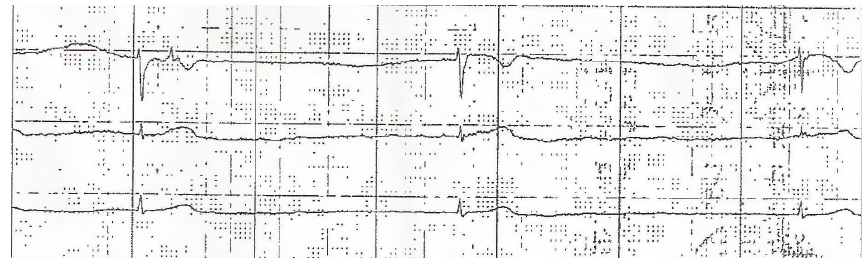
Figure 3: Telemetry rhythm strip showing sinus arrest with junctional escape rhythm at rate of 22 beats per minute.